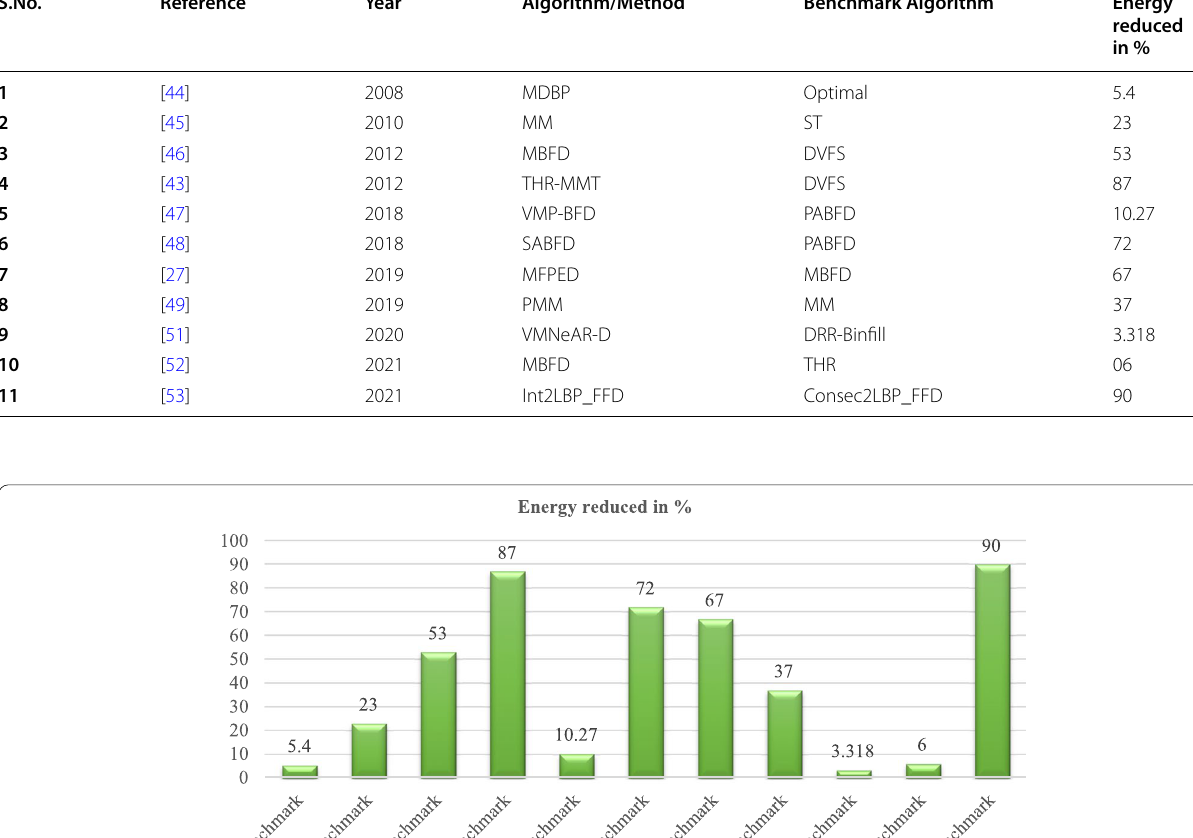
Table 2 Comparison of benchmark concerning Energy Consumption for Table 1 S.No.